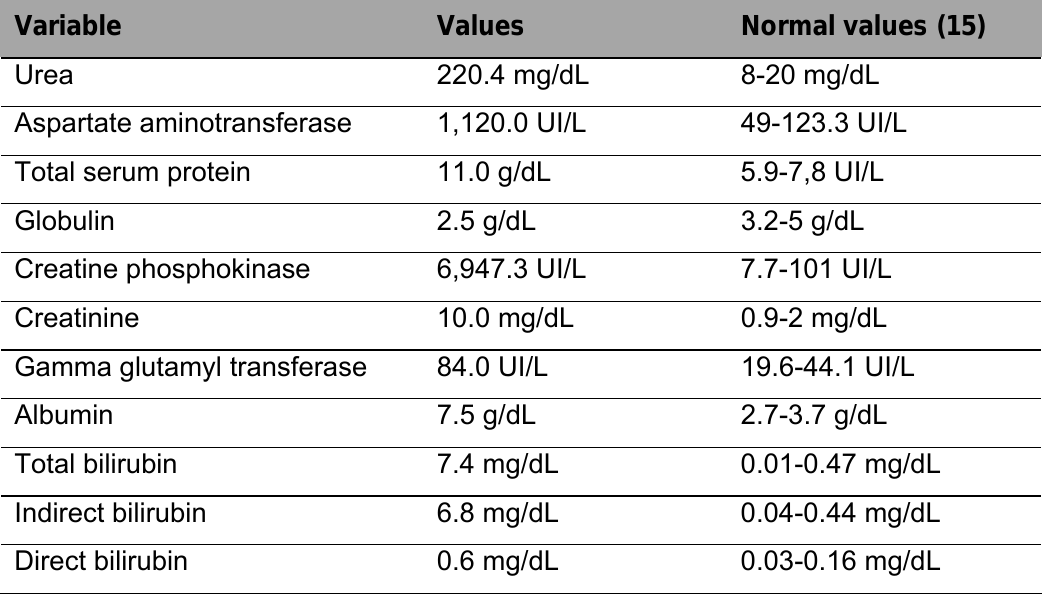
Table 2. Biochemical tests of a young ovine previously hyperimmunized with Crotalus durissus terrificus venom, 12 hours after